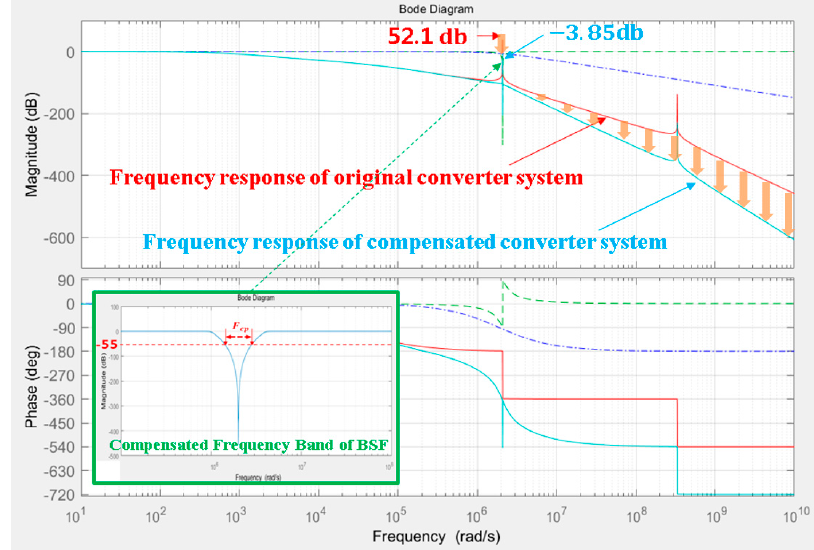
Figure 10. The comparison of the frequency response between the original converter system and the compensated system. compensated